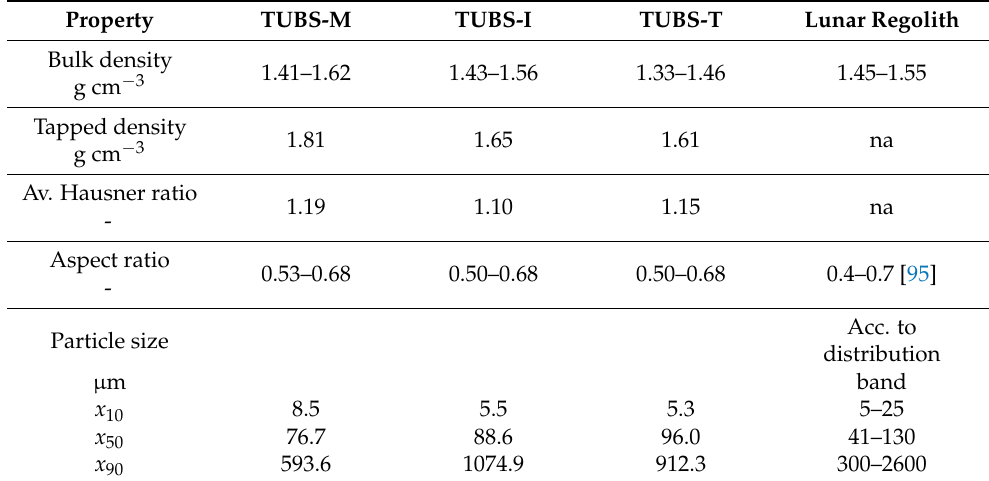
Figure 11. Volume reduction of the regolith simulants TUBS-M, TUBS-I, and TUBS-T as a function of the number of taps. Table 2. Physical properties of the investigated batch samples compared with lunar values taken from [28].